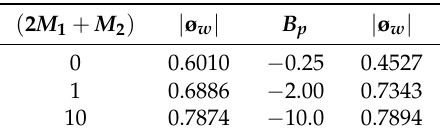
Figure 5. The effect of 𝐵 (cid:3043) on the velocity profile ( a ) and the volume fraction profile ( b ), when 𝑅 = 1 , 𝑚 = 0.5 , (2𝑀 (cid:2869) + 𝑀 (cid:2870) ) = 1 , 𝐵 (cid:3045) = −10 , 𝜙 (cid:3030) = 0.68 , 𝑆 = 100 , 𝐹𝑟 = 0.5 , 𝑁 = 0.4 .